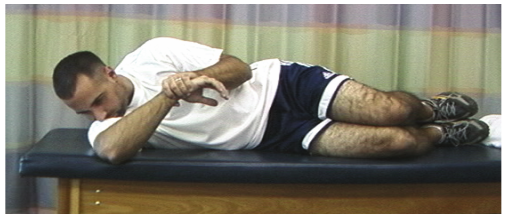
Figure 1: Sleeper stretch.